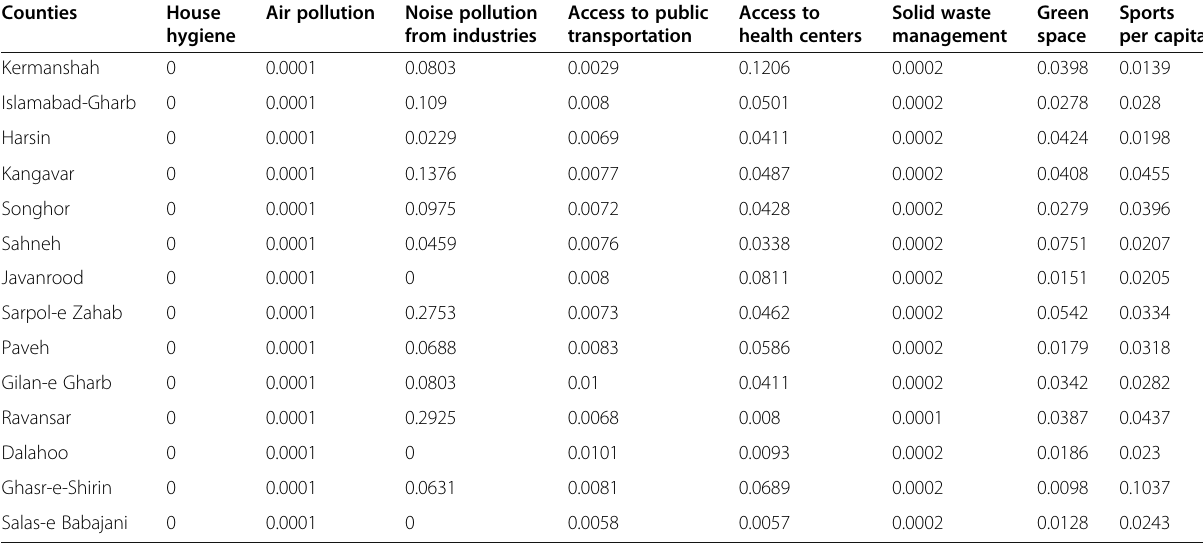
Table 4 Standardized weight matrix of indexes